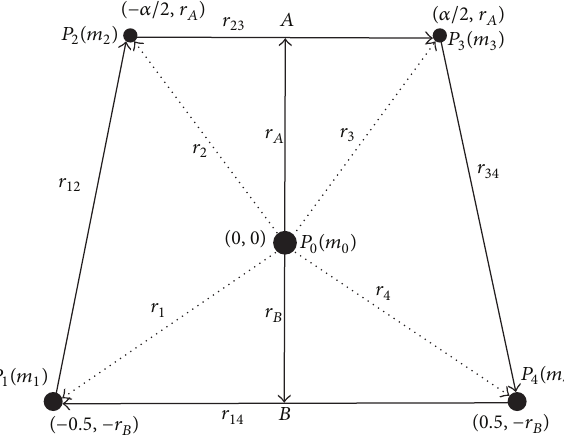
Figure 1: Trapezoidal four- and five-body